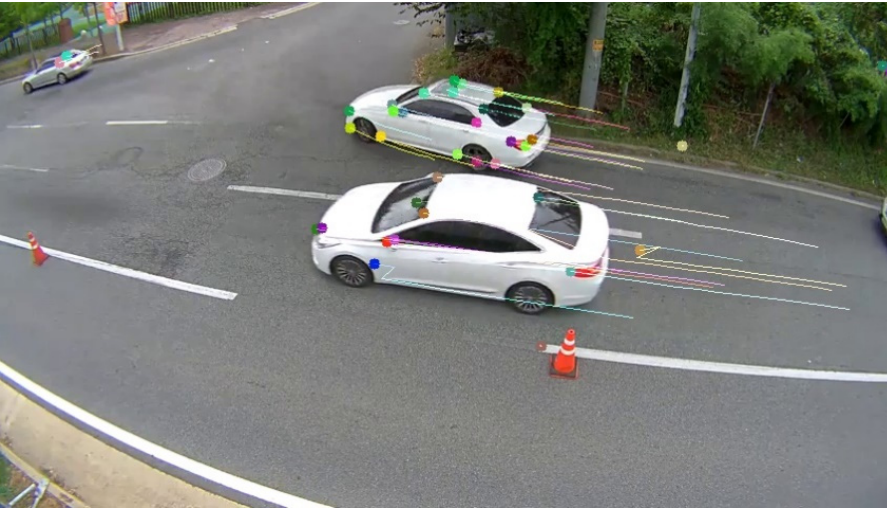
Figure 3. Detection with optical flow using the Lucas–Kanade method.